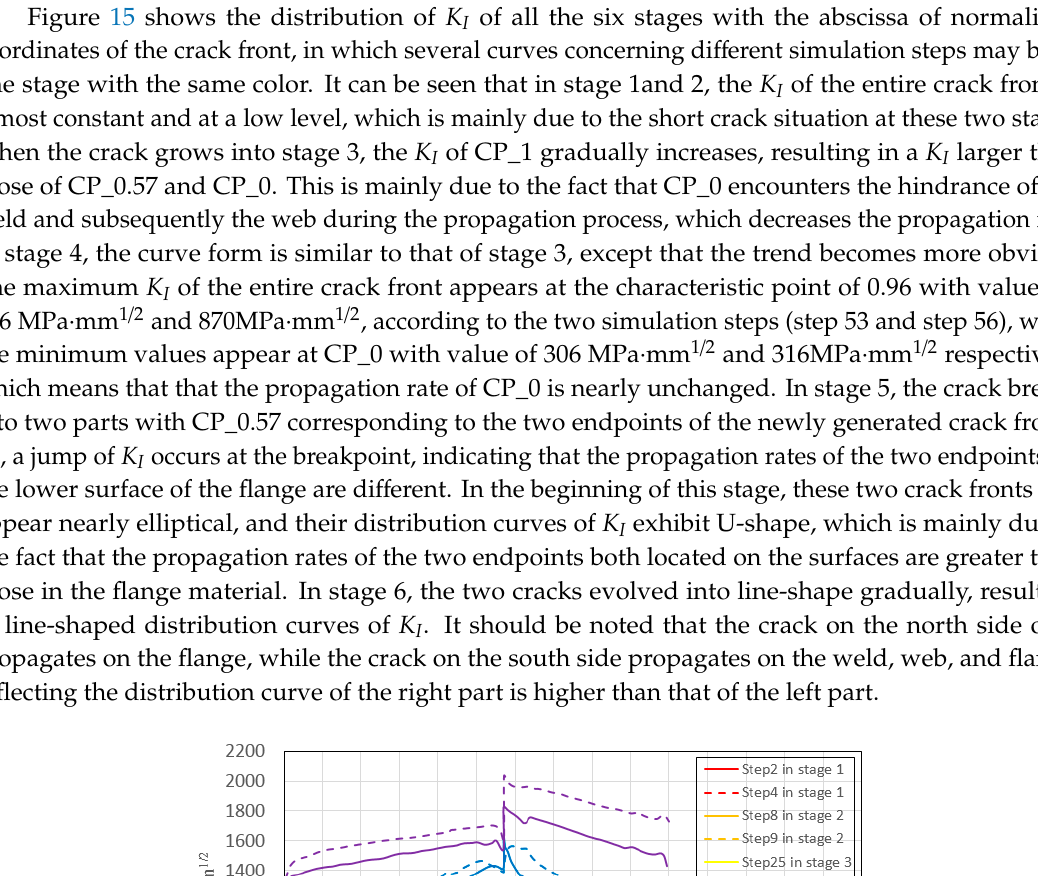
ff erent stages ( K + equ